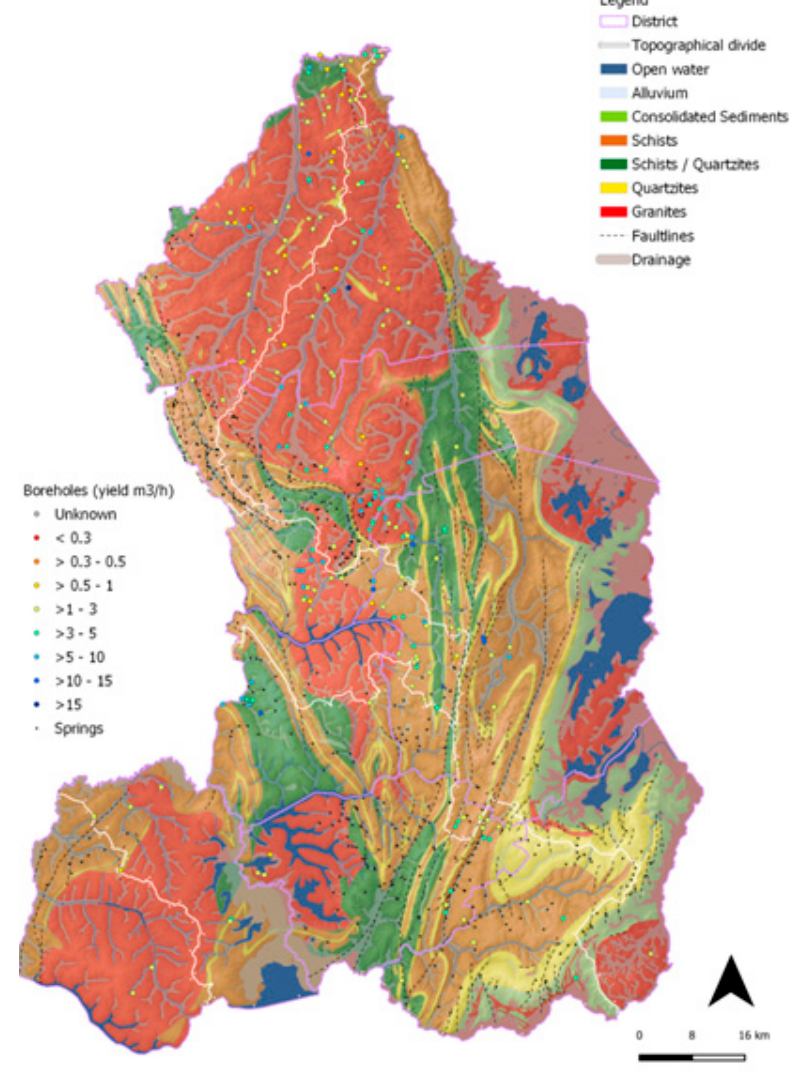
Figure 2. Eastern Province, Rwanda. Map shows hydrogeological features of the study area [76].